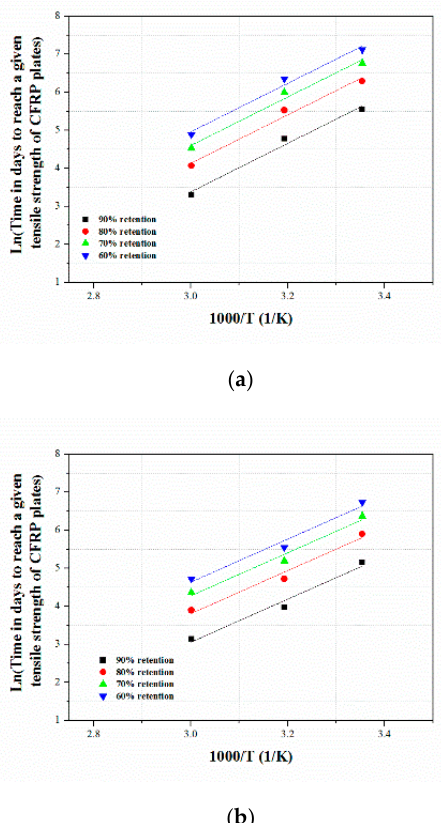
Table 5. Coe ffi cients of regression equations in Equation (4).